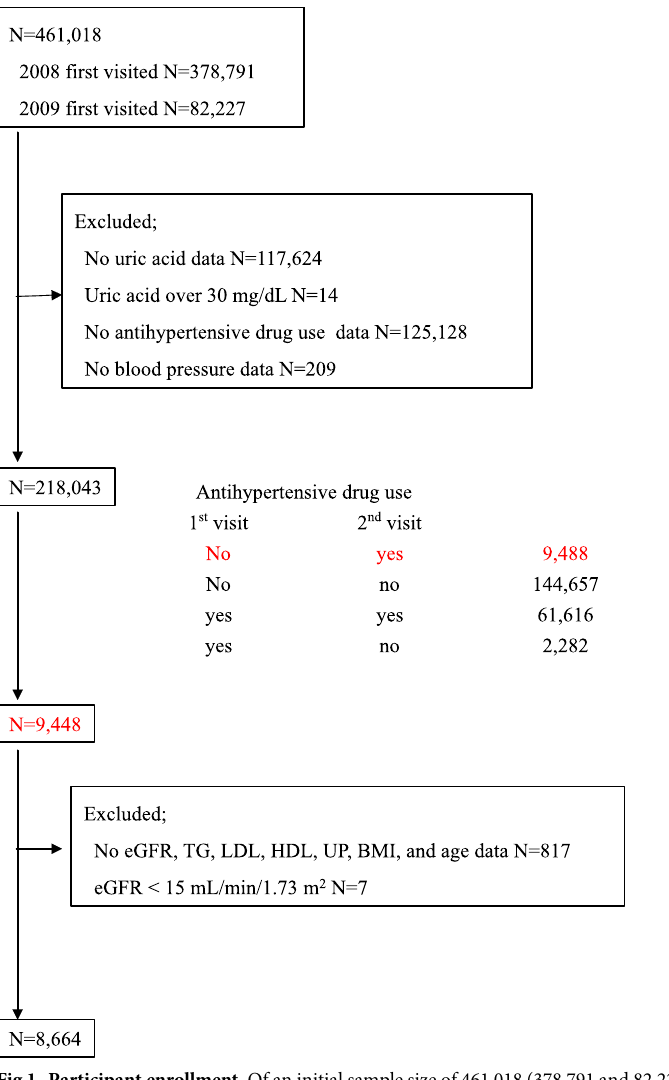
Fig 1. Participant enrollment. Of an initial sample size of 461,018 (378,791 and 82,227 participants who visited for the first time in 2008 and 2009, respectively), 242,975 participants were excluded because of missing uric acid data and unavailable information regarding antihypertensive drug (s) use, among others. Of 218,043 participants, 9,488 were eligible for this study (subjects who were not prescribed antihypertensive drugs on the first-year visit and prescribed antihypertensive drugs on the second-year visit). Further, 817 participants were excluded because of missing data on the following: eGFR, lipid, urine dipstick test, BMI, and age. In addition, seven participants were excluded because their eGFR was < 15 mL/min/1.73 m 2 . Finally, 8,664 participants were enrolled in this